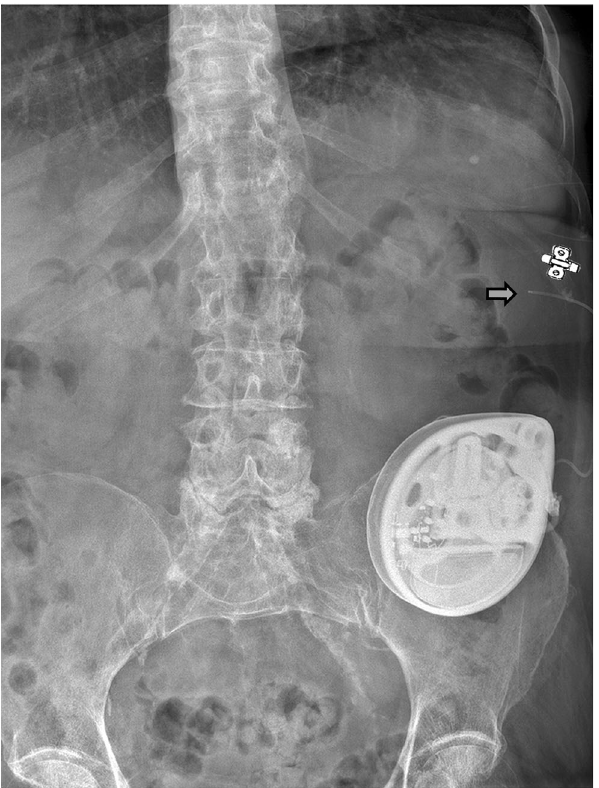
Fig. 9 Catheter 8731SC migration ( gray arrow ) caused by an open V- wing anchor ( anchor symbol ) in an 80-year-old woman with intractable pain and spasticity caused by failed back surgery syndrome, with a spinal cord lesion (SCL) T12 treated with intrathecal